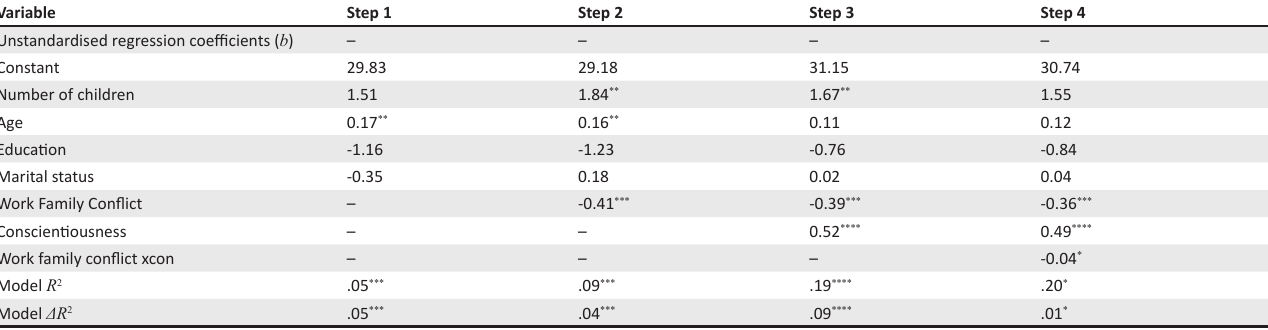
TABLE 2: Hierarchical regression analysis predicting work engagement from work-family conflict. Variable